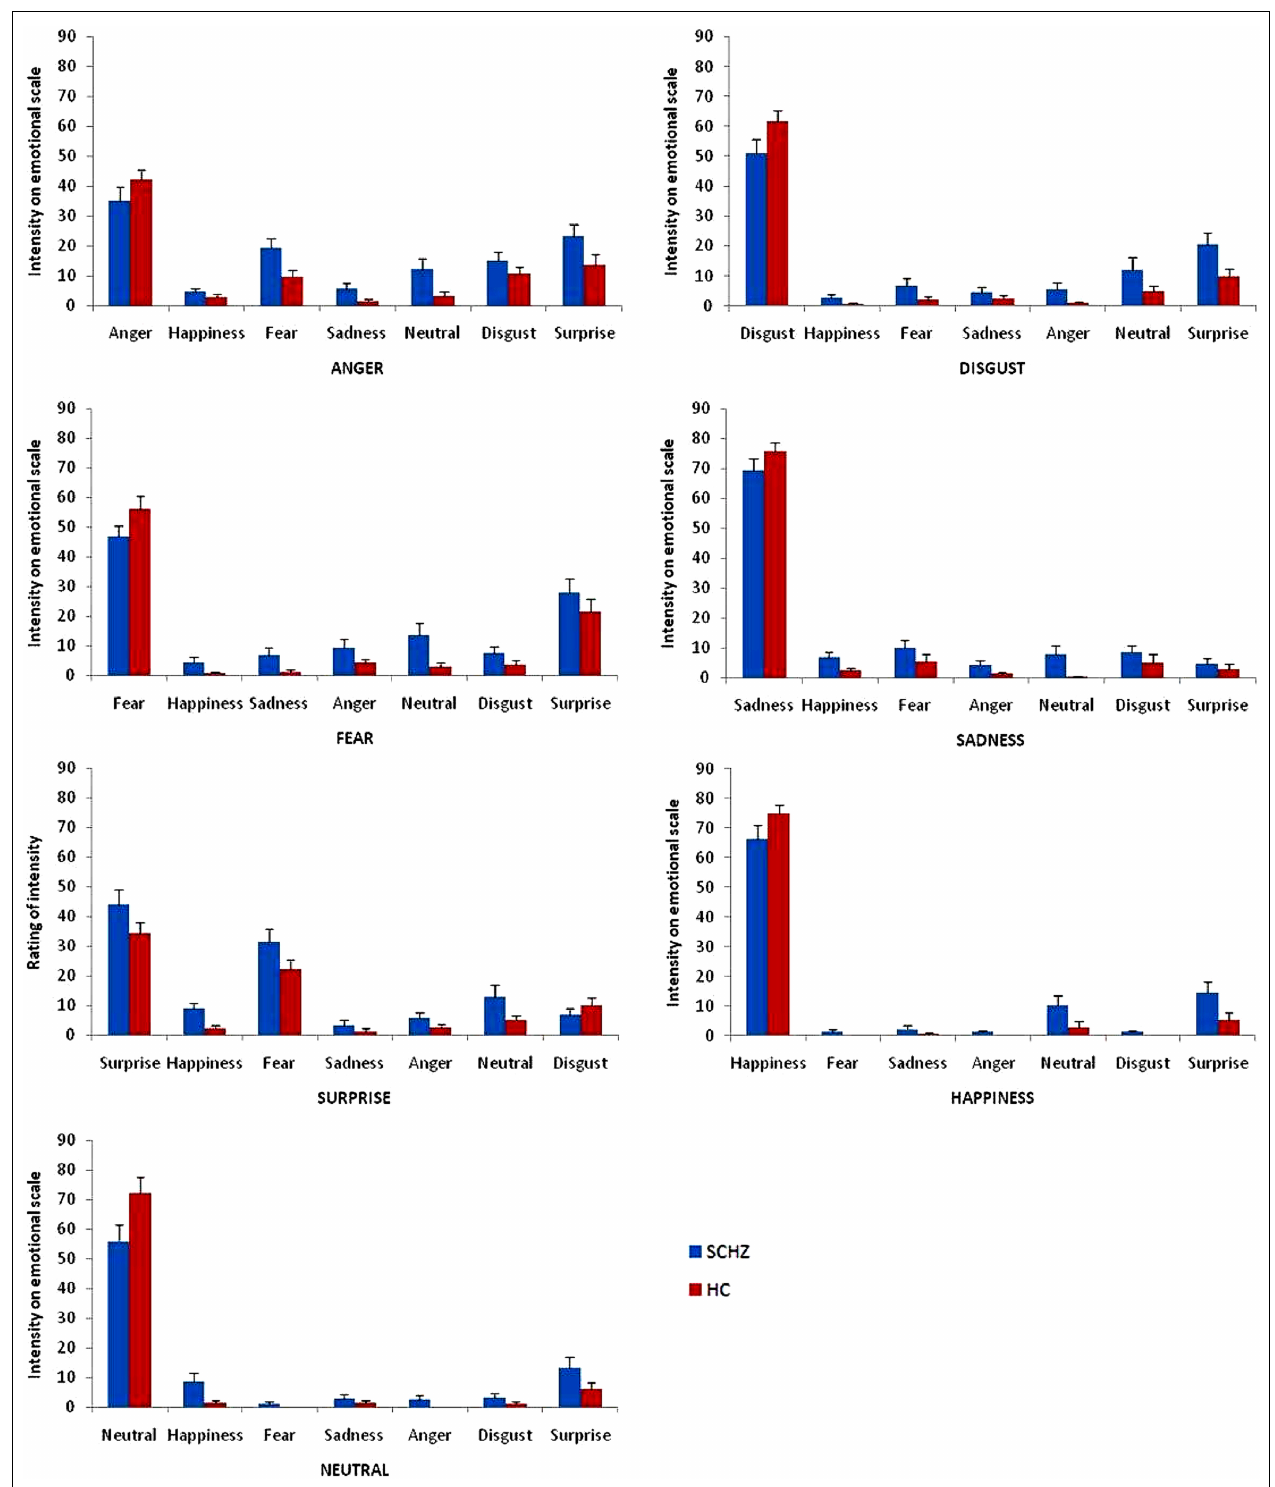
FIGURE 4 | Emotional biases on target and non-target scales for each category of emotional stimuli in the vocal emotion recognition task. Error bars indicate standard errors of mean.